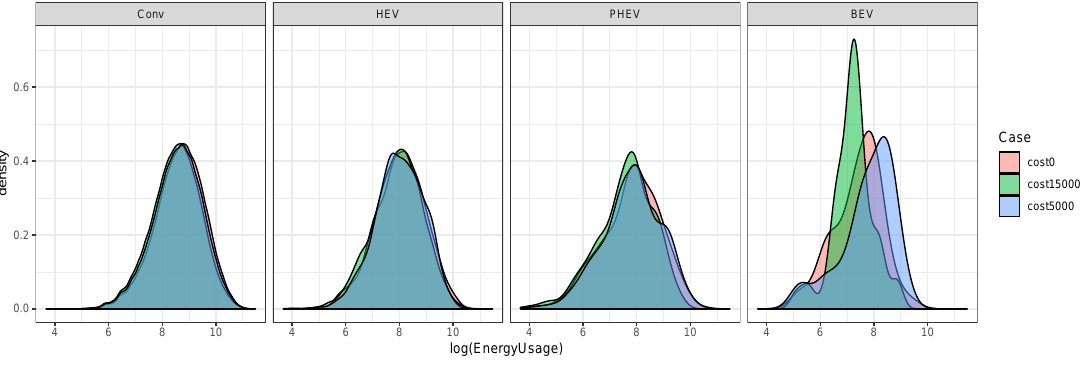
Figure 10. Density plot of log energy usage per